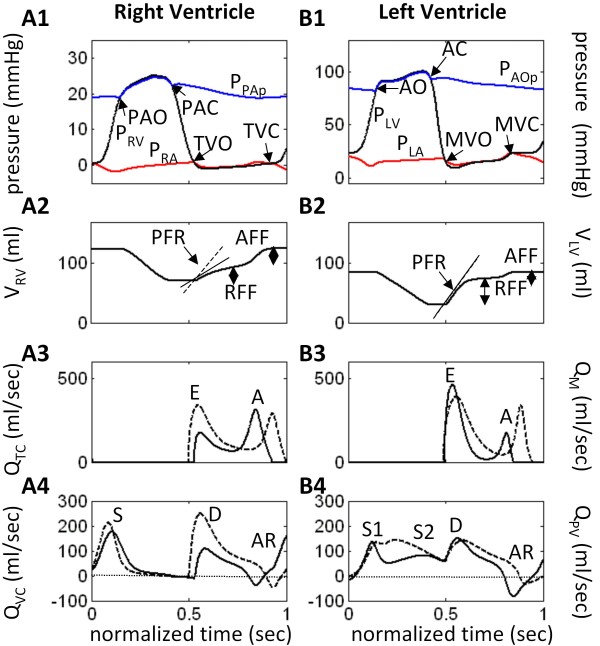
Model Waveforms for Restrictive Case. Model-generated pressure, volume and flow waveforms for restrictive case (R). Dashed line plots are the control case for comparison. Abbreviations are as in Figure 2. See text for details.